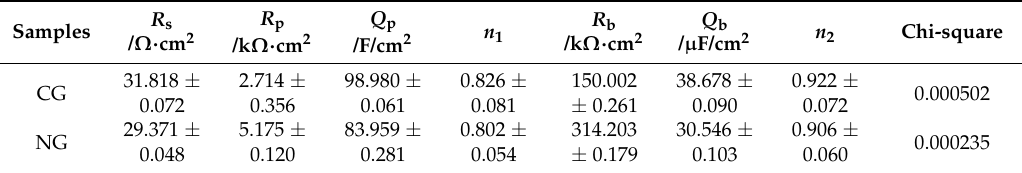
Table 2. Electrochemical impedance parameters of the CG and NG Ti–6Al–4V alloys in SBF solution at 37 ◦ C.